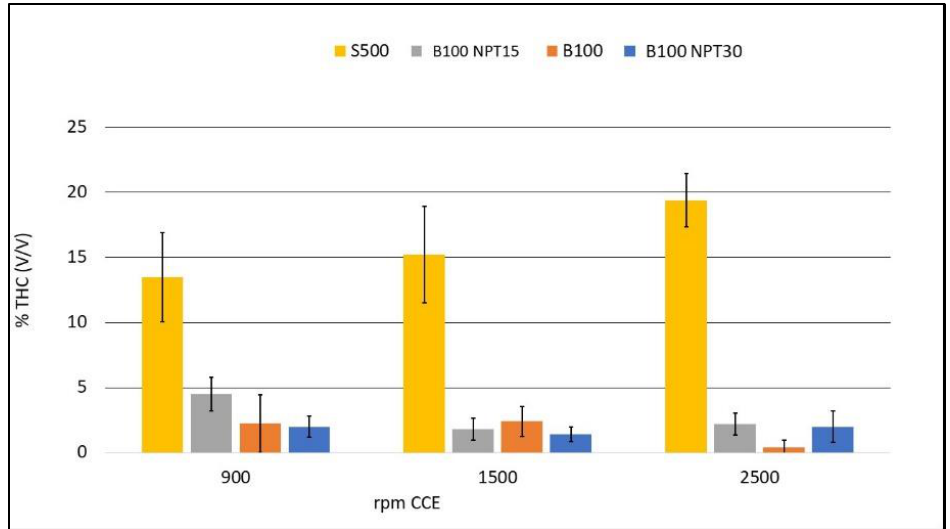
Figure 6. Emissions of THC (%, v / v ) with different engine rotations (rpm) for the fuels B100, B100-NTP15, B100-NTP30, and S500.